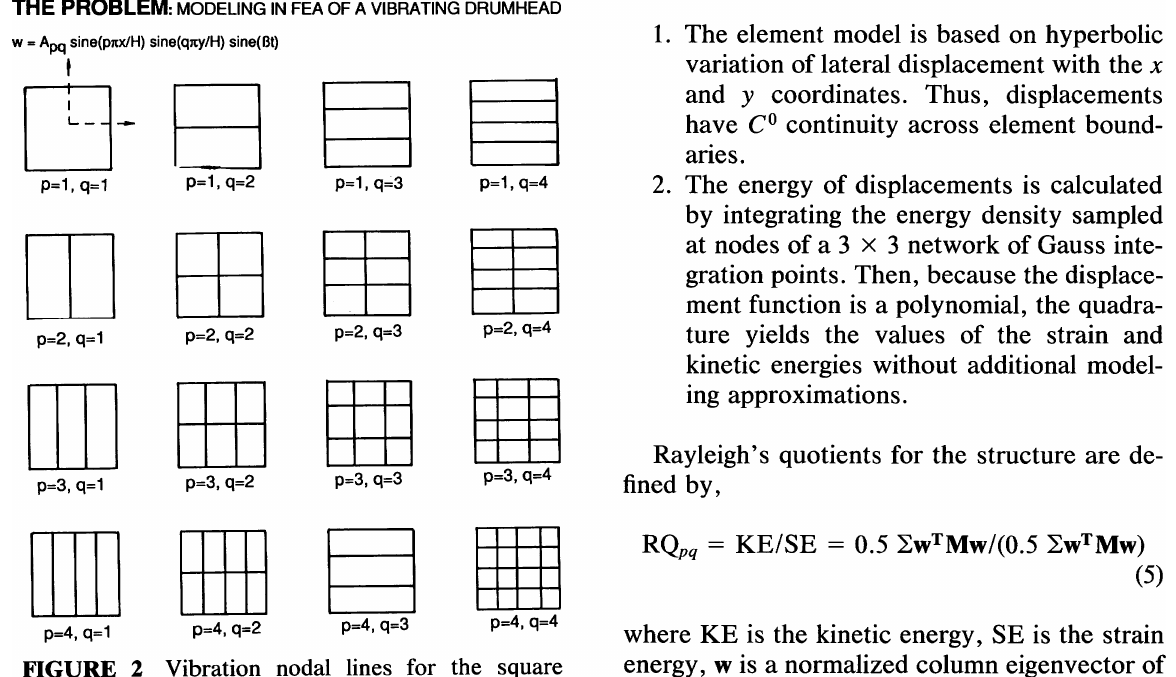
FIGURE 2 Vibration nodal lines for the square drumhead (first 16